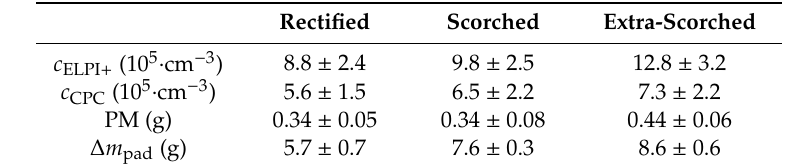
Table 5. Mean and standard deviation of the total measured particle concentration (c ELPI + and c CPC ), mass of the PM collected on the filters and the mass loss of the pads ( ∆ m pad ).